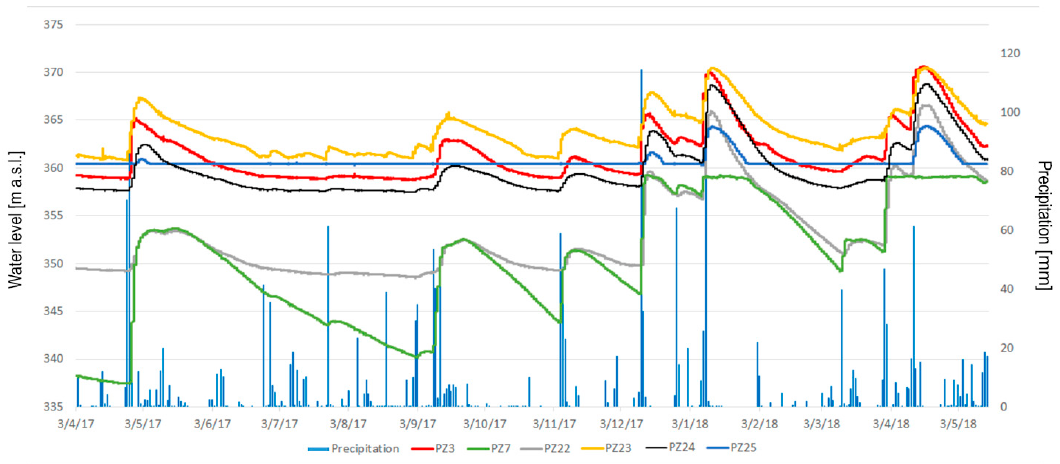
Figure 8. Data-logger water level measurements in the period April 2017–May 2018 with respect to the precipitations occurred in the study area in the piezometers PZ3, PZ7, PZ22, PZ23, PZ24 and